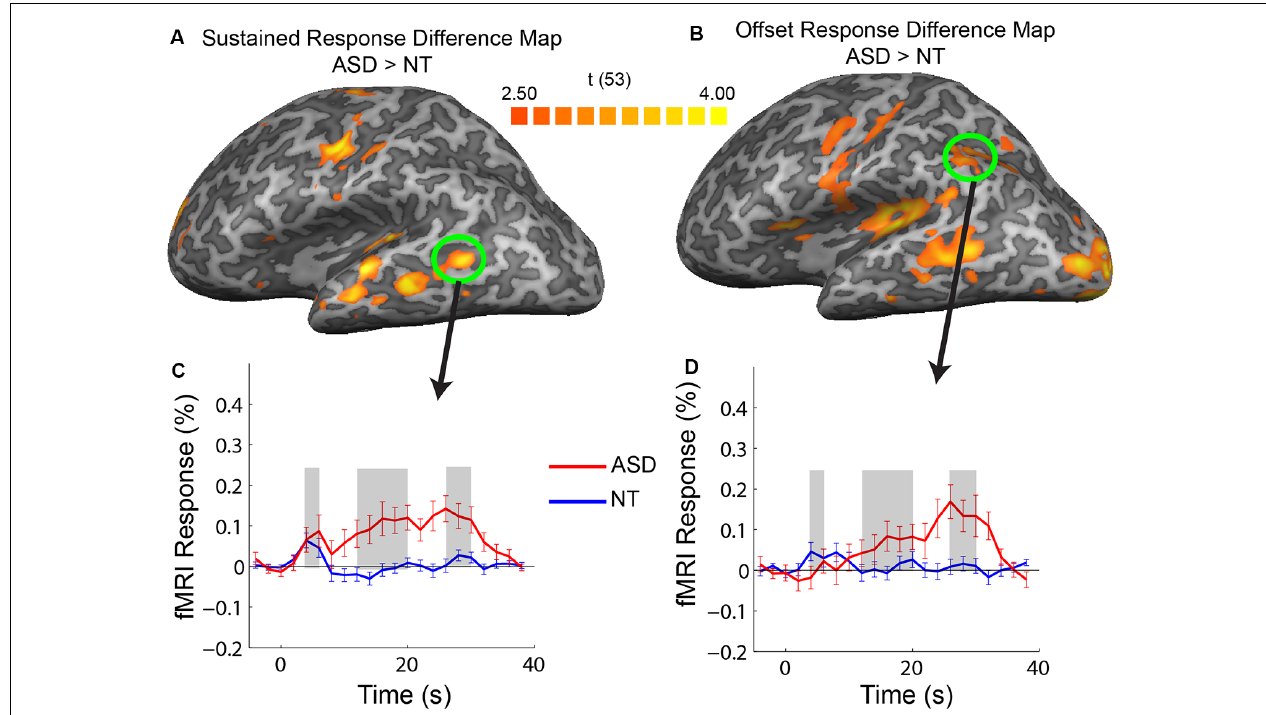
FIGURE 4 | Difference maps showing regions of increased response in ASD vs. NT in sustained (A) and offset (B) response amplitude. Averaged timecourses from example ROIs that did not correspond to regions strongly activated by the stimulus, in the posterior, middle temporal region (C) and posterior parietal (D)